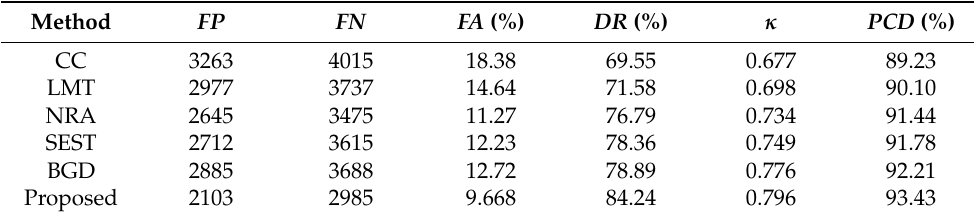
Table 2. Comparison of results from all the six methods using dataset 2 before median filtering.